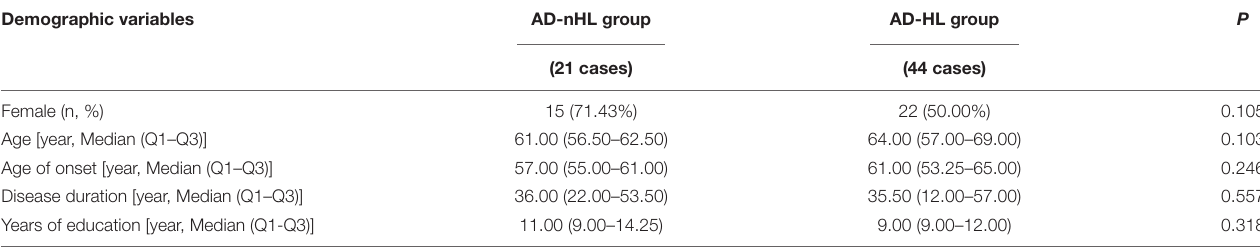
TABLE 1 | Demographic variables of Alzheimer’s disease with no hearing loss (AD-nHL) and Alzheimer’s disease with hearing loss (AD-HL) groups. Demographic variables